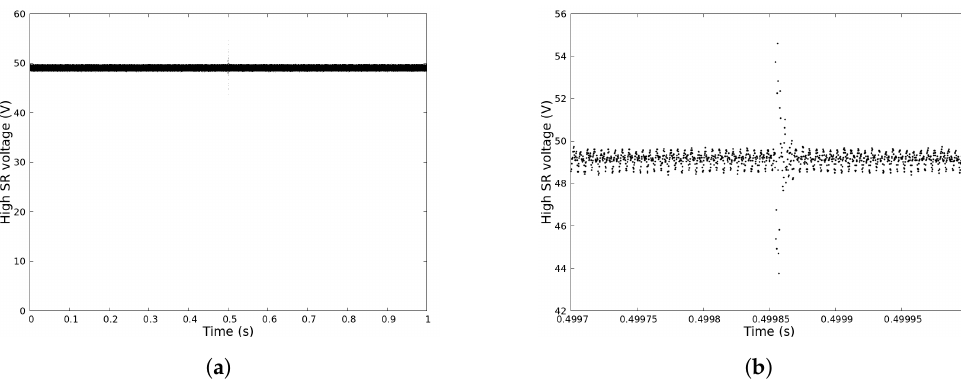
Figure 10. Triggered slope event in the real micro-grid: complete waveform ( a ) and zoomed ( b